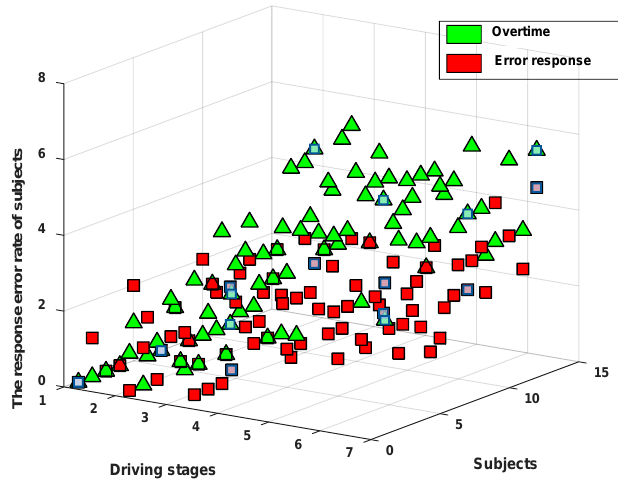
Figure 5. The response error rates of the